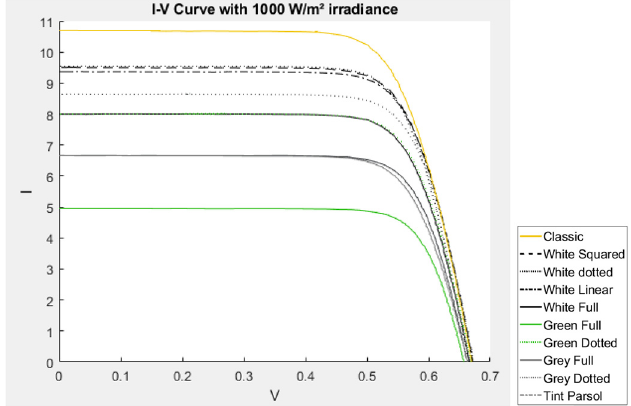
Fig. 6. I – V characteristics measured at 1000W/m 2 , for the different color/pattern coated PV laminates of the